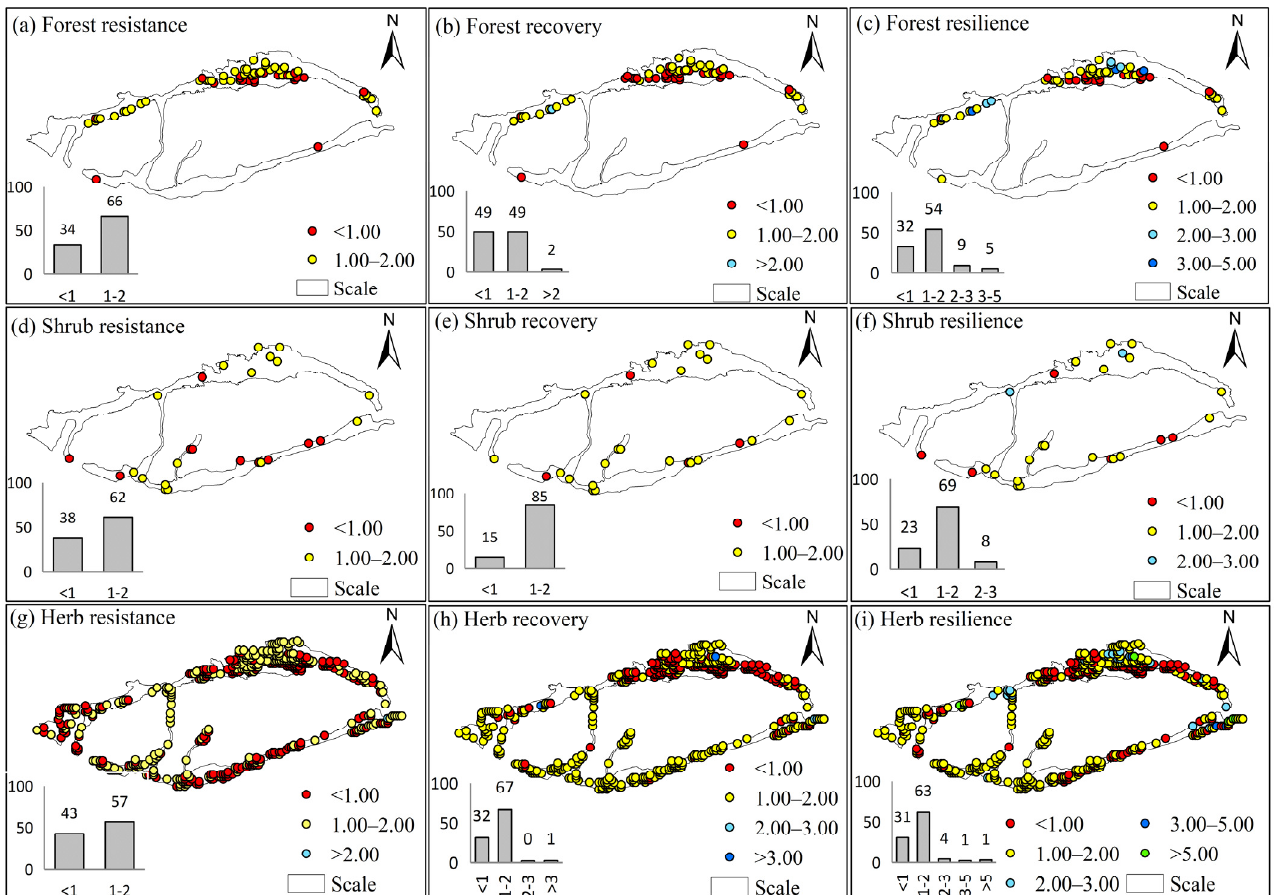
Figure 4. Spatial variations in resistance, recovery, and resilience of the different plant communities under two different drought conditions.